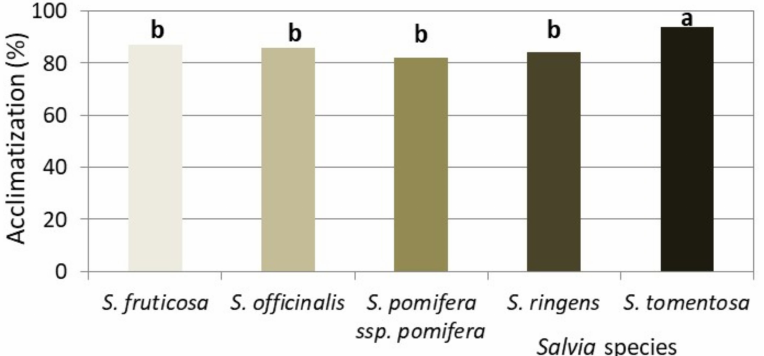
Figure 13. Ex vitro acclimatization of rooted microshoots of Salvia spp., on a peat–perlite substrate 1:1 ( v / v ) (n = 6–10 repetitions of 8 rooted